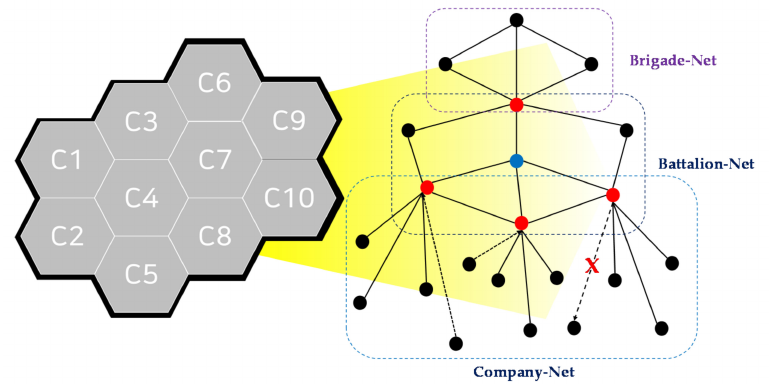
Figure 8. Overview of VMF-based CNR testbed with ad hoc and static cell-planning concepts.